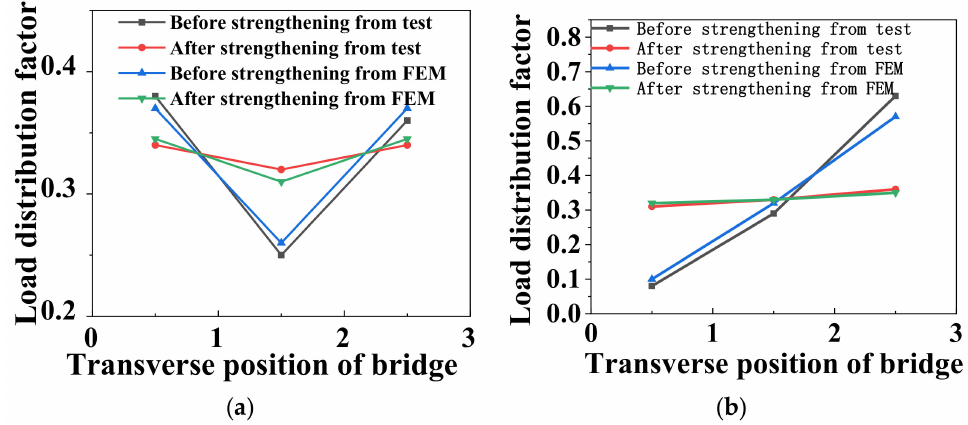
Figure 16. Comparison of load distribution factors between the test and FE analysis. ( a ) Symmetrical loading. ( b ) Partial loading.